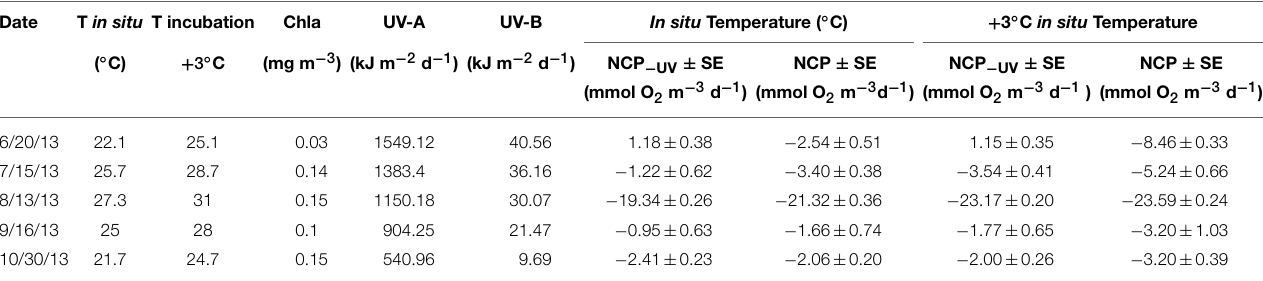
TABLE 1 | In situ and warming incubation temperature ( ◦ C), chlorophyll a concentration (mg m − 3 ), daily UV-A and B doses (kJ m − 2 d − 1 ), net